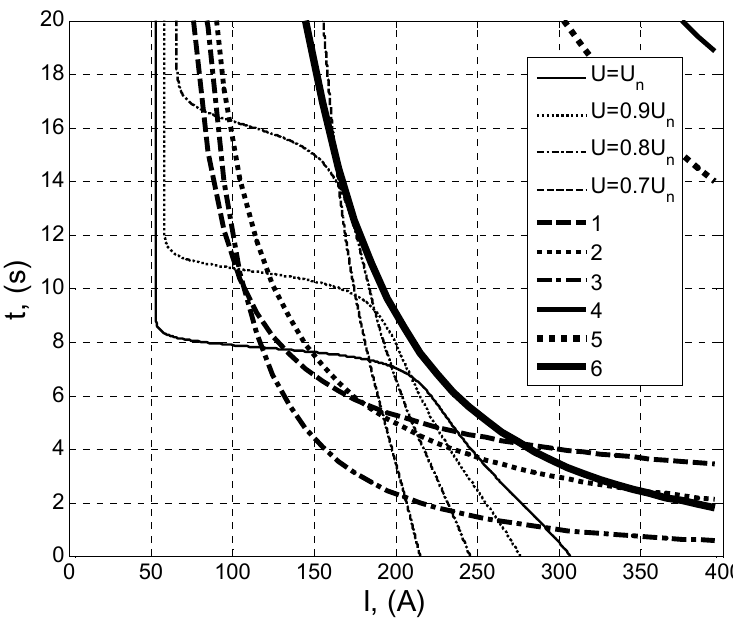
Figure 7. Proposed time-current characteristic of an overcurrent protection for an induction motor powering the auxiliary jet fan against the time-current characteristics of overcurrent protections with characteristics in accordance with References [4,16] and time courses of RMS values of starting currents of this motor for various stator voltages.